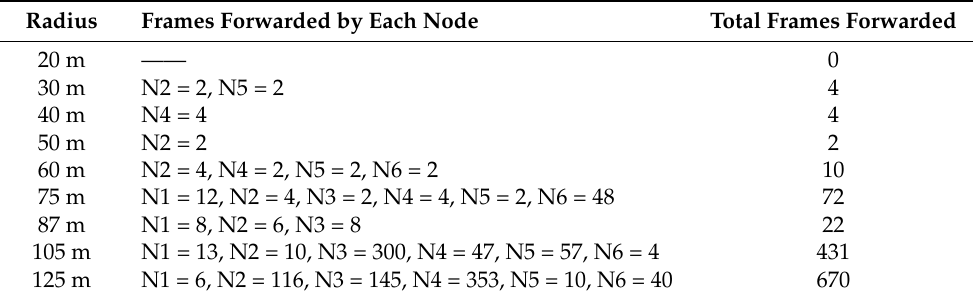
Table 4. Frames forwarded for different array